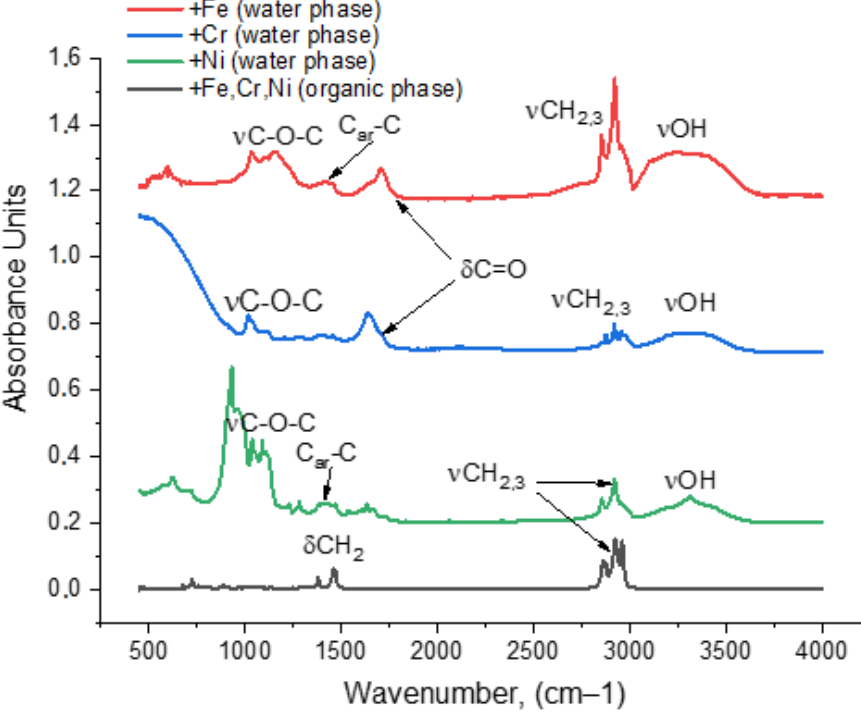
Figure 4. IR-spectra of catalytic n-hexane oxidation products (organic and water phases).